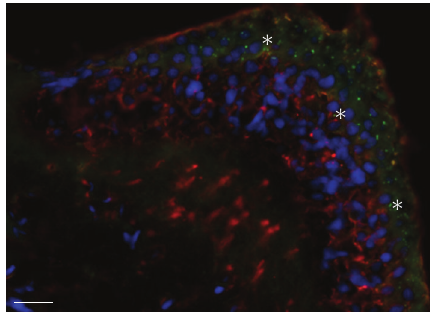
Figure 3: Distribution of RyRs in the frog Crista ampullaris . Representative immunofluorescence obtained from 18 μ m thick crista slices. Tissues were treated with monoclonal anti-RyR antibodies (green) and polyclonal anti-tubulin beta III antibodies (red); nuclei were counterstained blue with DAPI. Labelling for RyR was observed in hair cells but not in nerve fibers, whereas the opposite pattern was observed for tubulin (except for a faint staining at the apex). Labeling for RyRs appeared to be stronger in spots above the hair cell nuclei; no clear di ff erence was noted among crista regions. In several regions (asterisks), tubulin-positive nerve arborizations came close to RyR-positive spots. The micrographs are representative of seven separate experiments. Bar: 20 μ